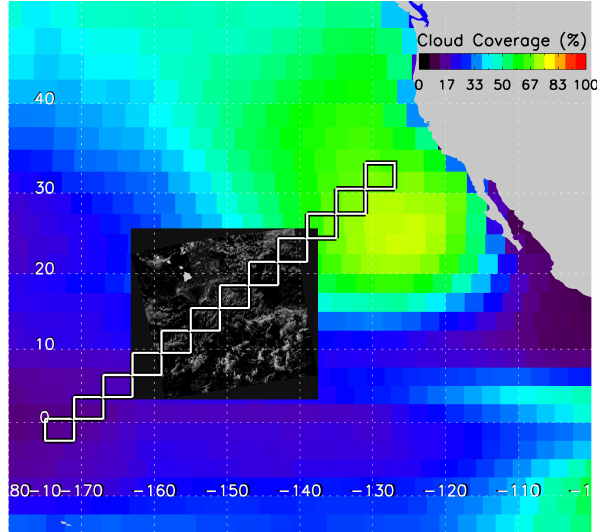
Fig. 1. Shown is the primary region of interest in the northeastern Pacific Ocean along the GPCI transect (white boxes; Karlsson et al., 2010; Teixeira et al., 2011). The colored background is the mean low-cloud amount according to ISCCP (Rossow and Schiffer, 1999) for a July composite from 2003 to 2010. The overlay is a snapshot image from the 0.65µm channel of MODIS from 1 July 2007.